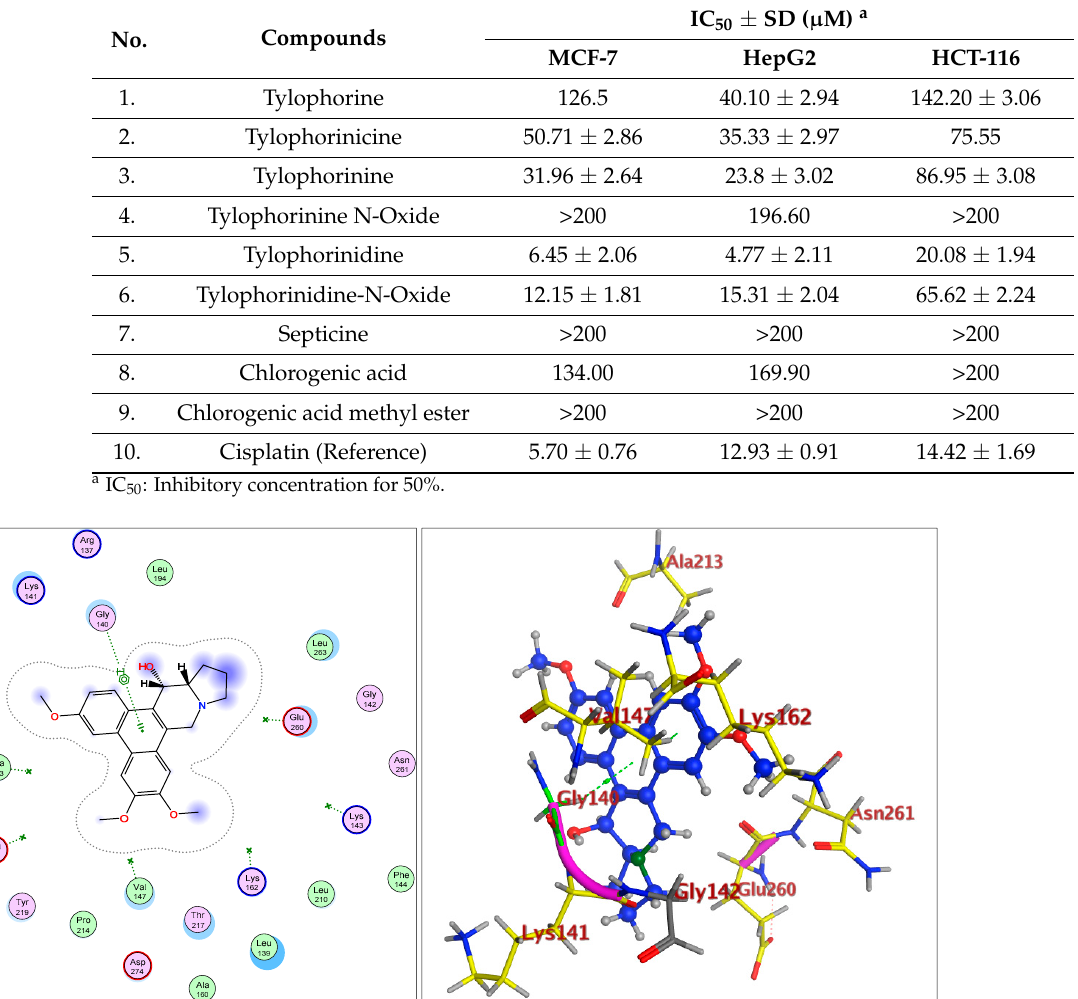
Table 2. Cytotoxic activity of the isolated compounds from Tylophora indica using MTT assays.